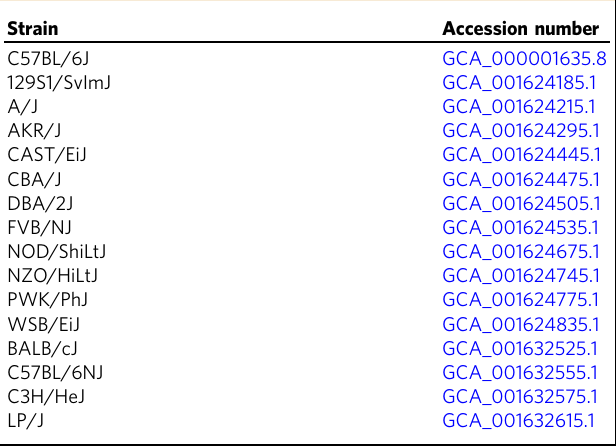
Table 1 Accession numbers of the assembled mice genomes available at